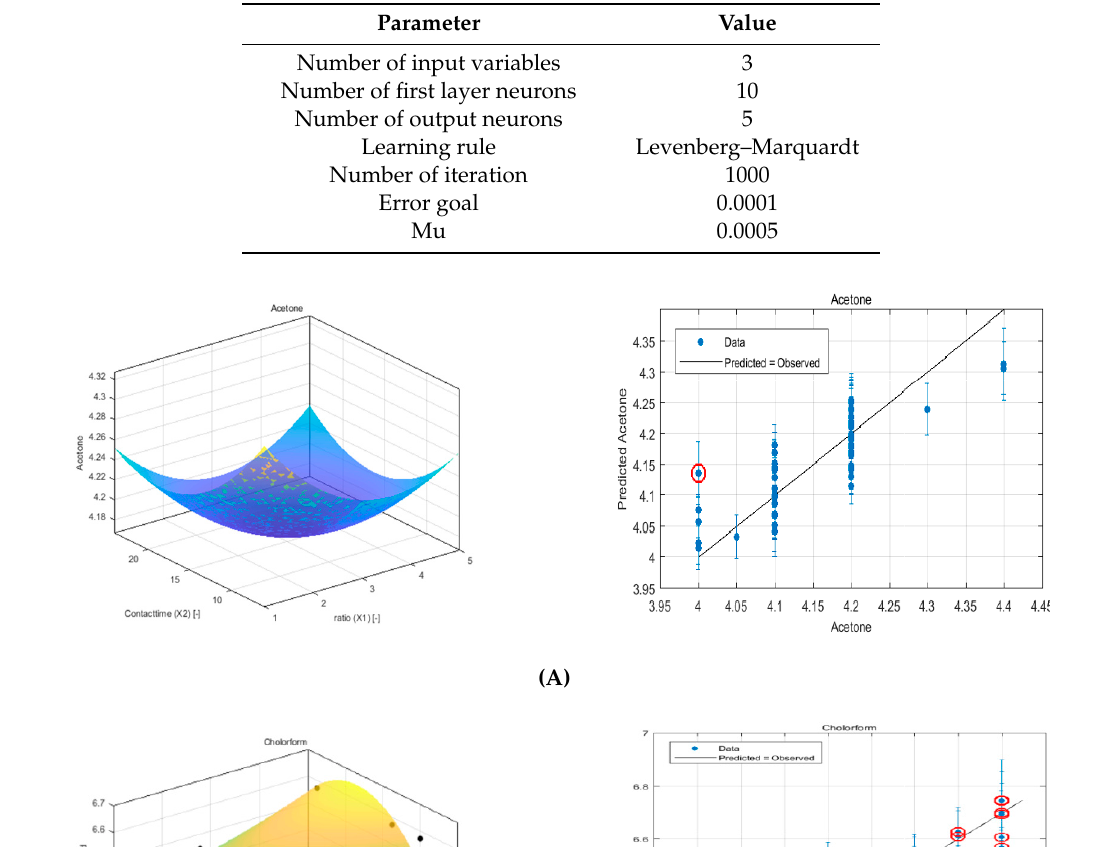
Table 3. ANN parameters value.